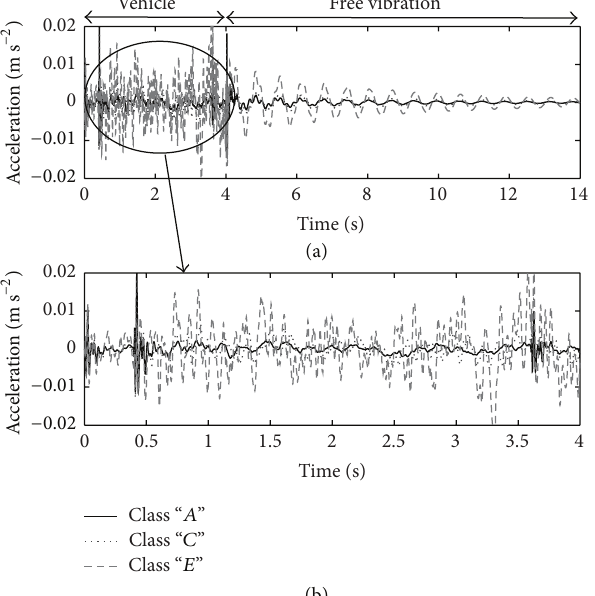
Figure 9: Effect of road surface roughness on lateral pier top acceleration response, (a) forced and free vibration for Classes 𝐴 , 𝐶 , and 𝐸 and (b) forced vibration only.